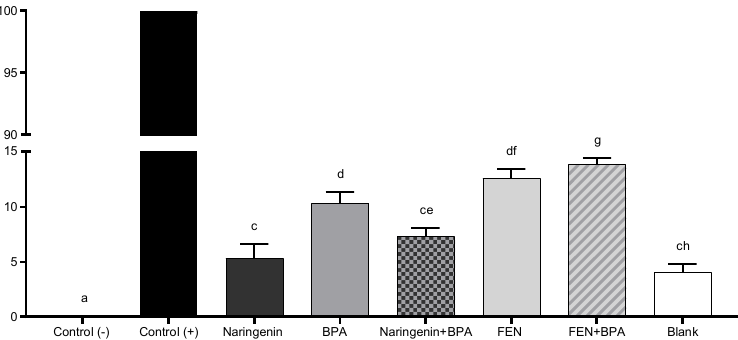
Figure 5. The effect of 250 µM naringenin, 4.4 µM BPA, 37% FEN, co-treatment naringenin + BPA or co-treatment FEN + BPA, and blank of fermentation (10%) on HT-29 cells was evaluated after 24 h incubation by LDH cytotoxicity assay. The total LDH controls can also be used to calculate the total effect of a specific condition. The experimental data are expressed as the mean value ± SD of the three independent experiments with three replicates of each one. Letters indicate statistical difference ( p < 0.05).